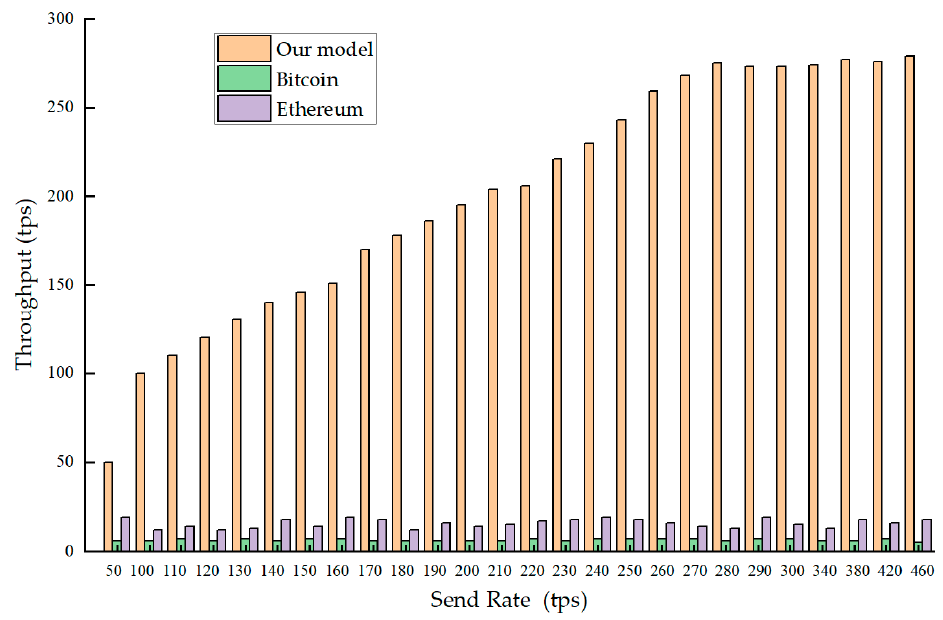
Figure 7. Performance comparison results of the methods.